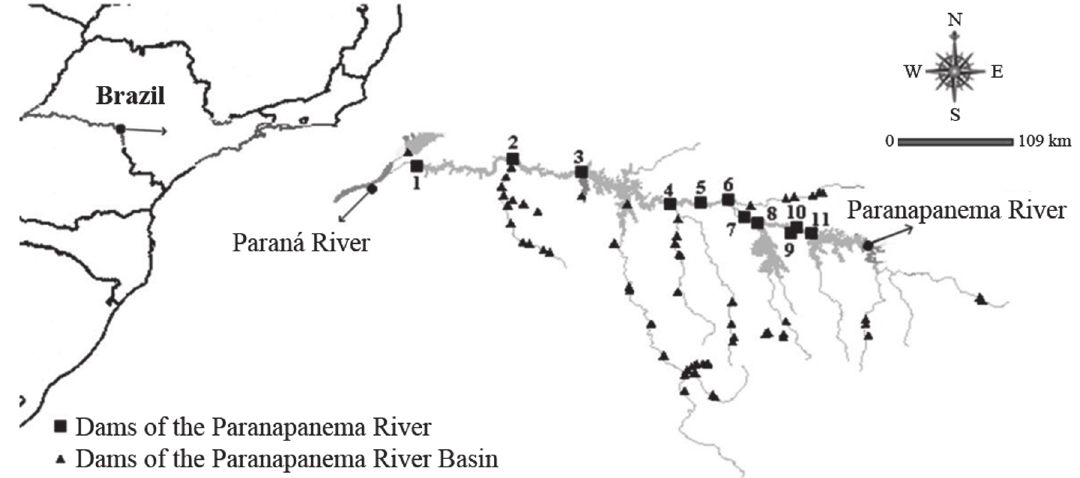
Fig 1 . Location of Paranapanema River in Brazil. In detail on the right the sequence of 11 dams constructed on the river (ANEEL 2012): 1- Rosana, 2 - Taquaruçu, 3 - Capivara, 4 - Canoas I, 5 - Canoas II, 6 - Salto Grande, 7 - Ourinhos, 8 - Chavantes, 9 - Paranapanema, 10 - Piraju, and 11 - Jurumirim. Other dams in tributaries are shown as